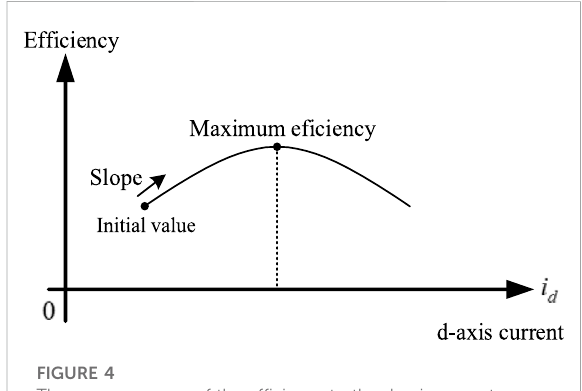
FIGURE 4 The concave curve of the ef fi ciency to the d-axis